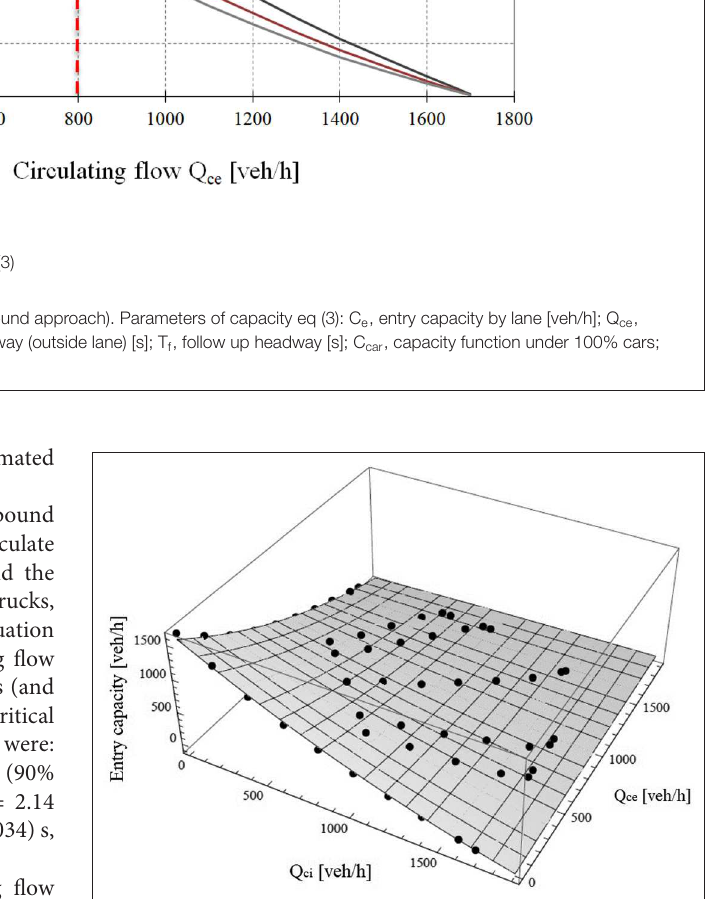
FIGURE 8 | Empirical surface vs. simulated capacities: left lane at roundabout 2 (Westbound approach). Q ce , circulating flow on the outside lane [veh/h]; Q ci , circulating flow on the inside lane